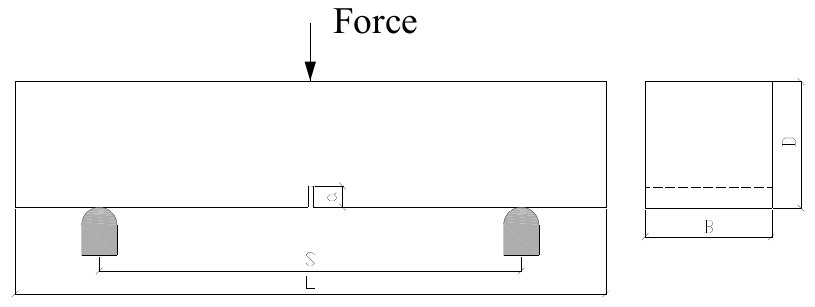
Figure 2. Schematic diagram of the specimen.